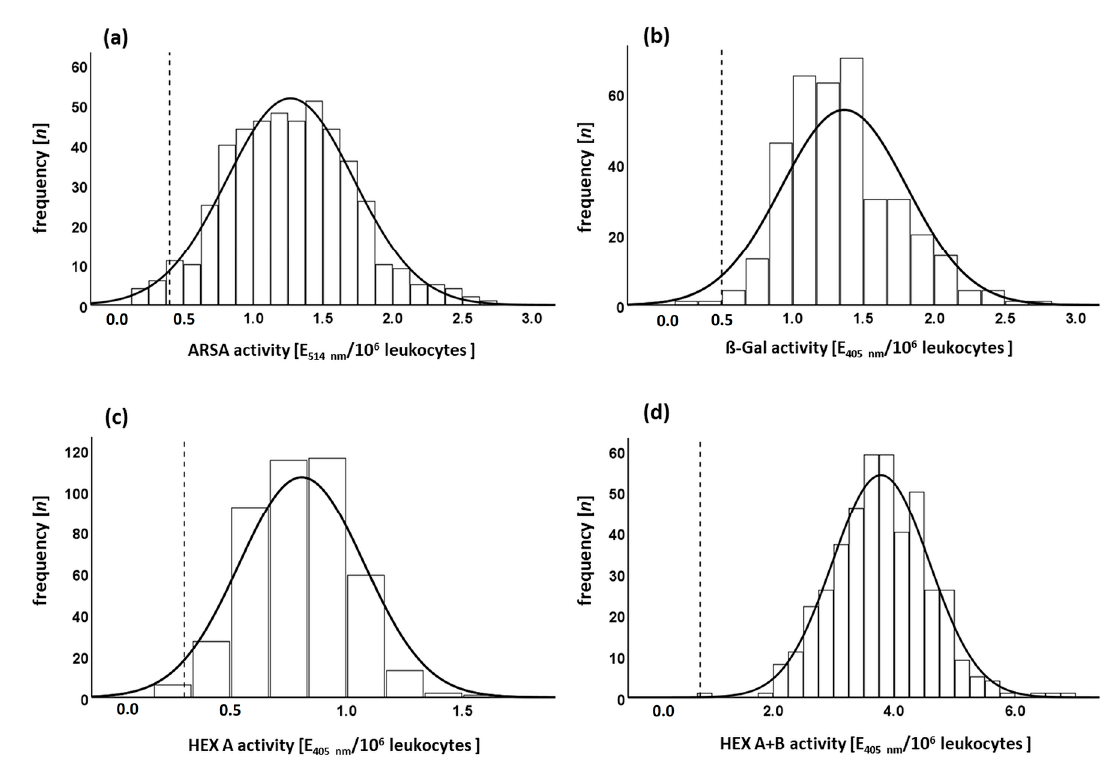
Figure 3. Enzyme activities in normal cohorts: Frequency distributions of enzyme activities measured in the normal cohort show a normal Gaussian distribution. Set minimal permissible values are indicated as dashed vertical lines. ( a ) The average arylsulfatase A activity (ARSA) was 1.27 ± 0.46 E 514nm / 10 6 leukocytes ( n = 474), and 2.3% of the samples were a false pathological with measured values below the minimal permissible value (0.4 E 514nm / 10 6 ); ( b ) The average β -galactosidase activity ( β -Gal) was 1.36 ± 0.44 E 405nm / 10 6 leukocytes ( n = 369), and 0.5% of the samples were false pathological with